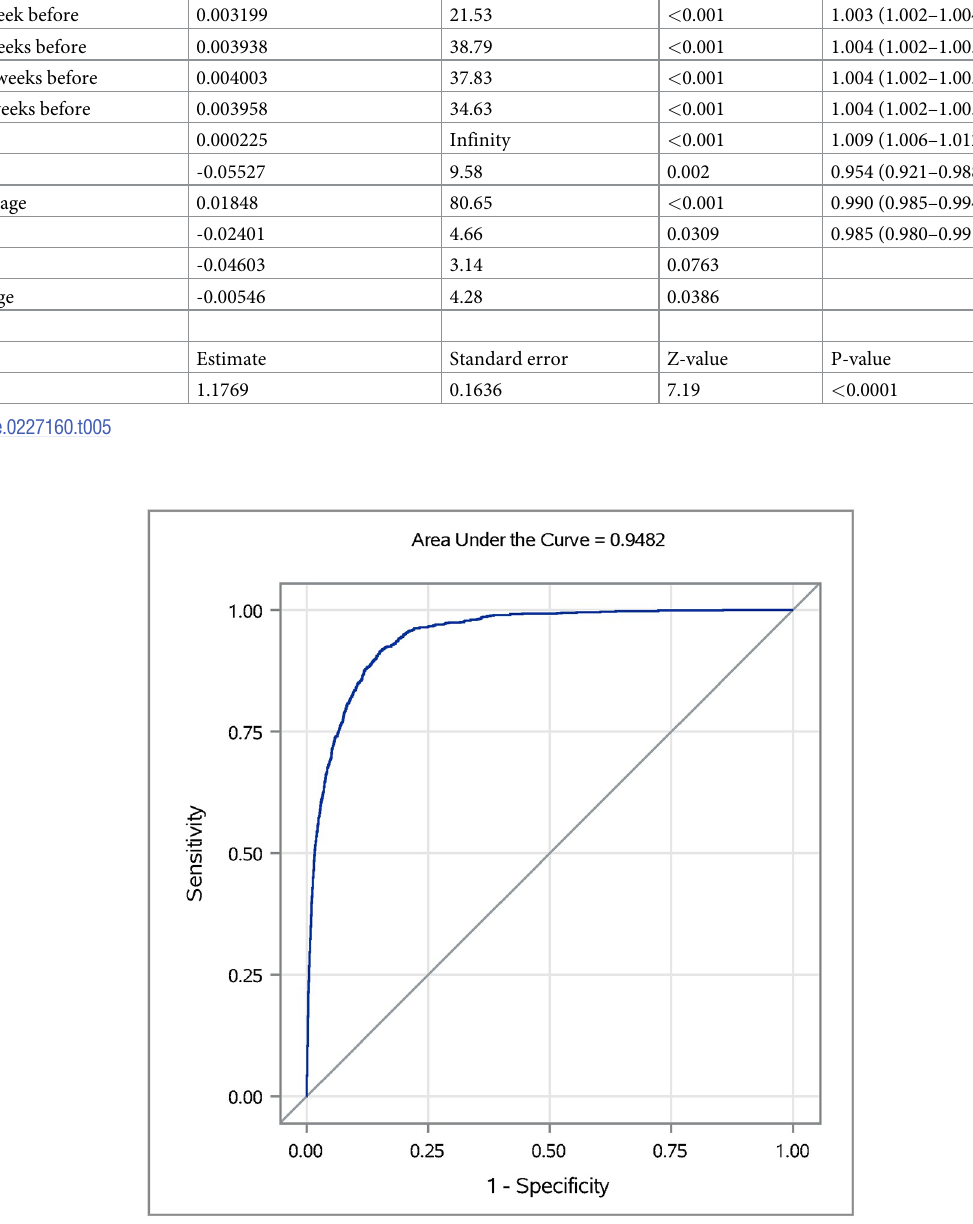
Fig 6. The receiver operating characteristics (ROC) curve for the final best-fit model for human West Nile virus cases in the Chicago area, based on weather, land cover, mosquito infection, and demographic